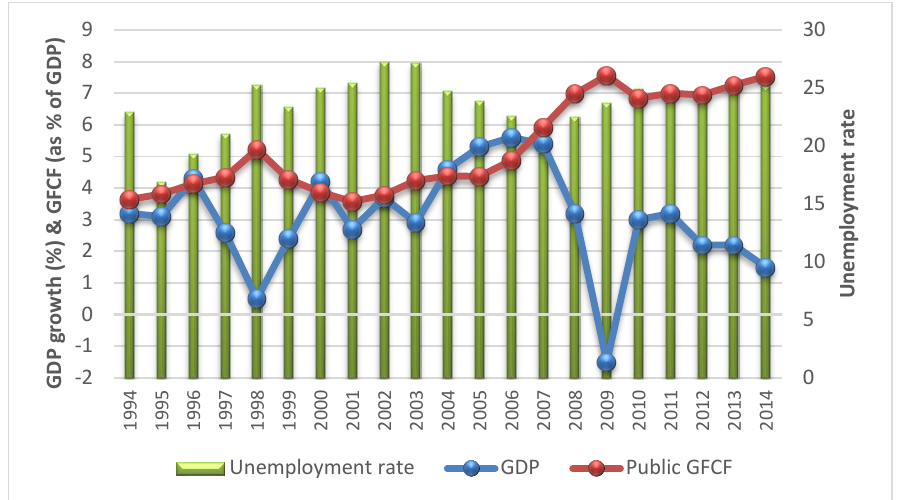
FIGURE 1: GDP growth, public GFCF as % of GDP, and unemployment rate Source: South African Reserve Bank